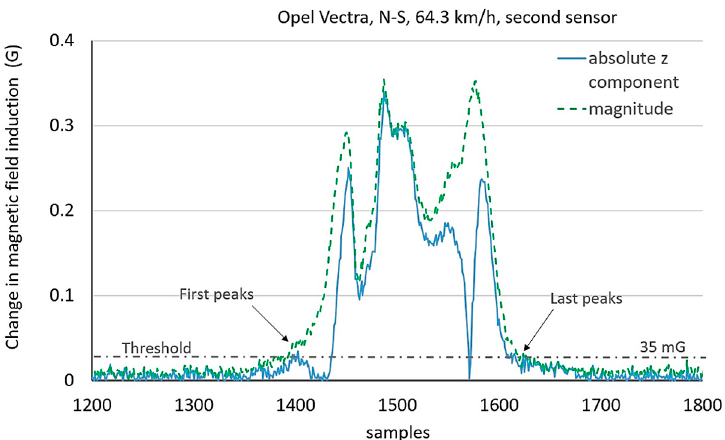
Figure 7 . Problem of little peaks and too big threshold baseline considering absolute z -component and magnitude of magnetic field signal.